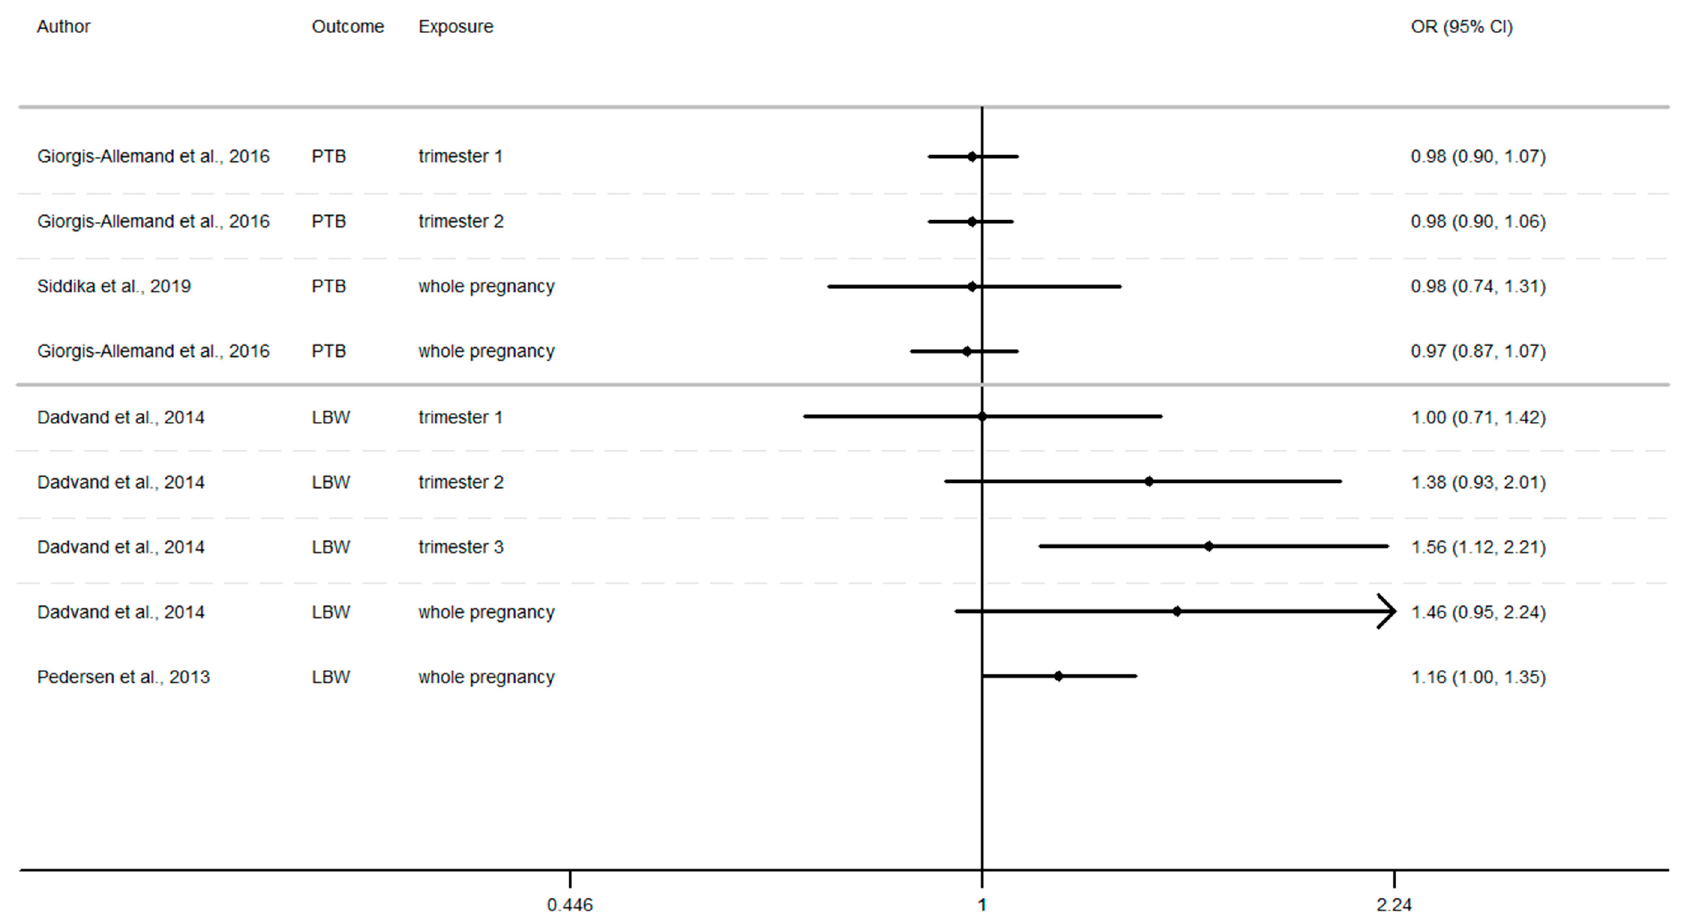
ff erent windows of exposure during